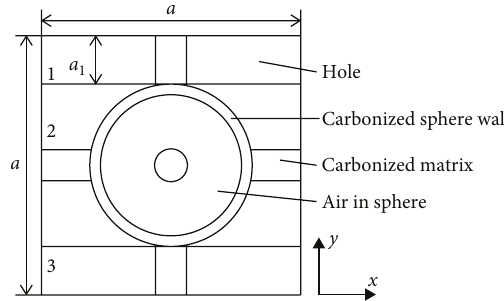
Figure 20: Unit cell of the crosslinked model.